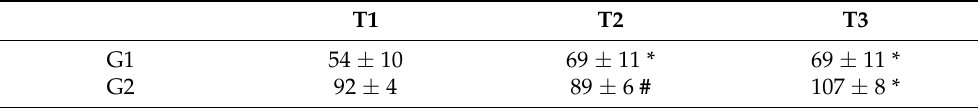
Table 1. Mean, standard error of the number of words read in 1 min for the two groups of children with dyslexia tested in the three different time periods. * Indicates a significant difference with respect to T1, while # indicates a significant difference with respect to T3.